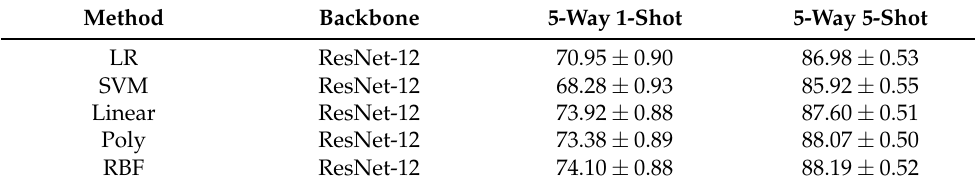
Table 7. Comparison results of different methods in the RSD46-WHU dataset.